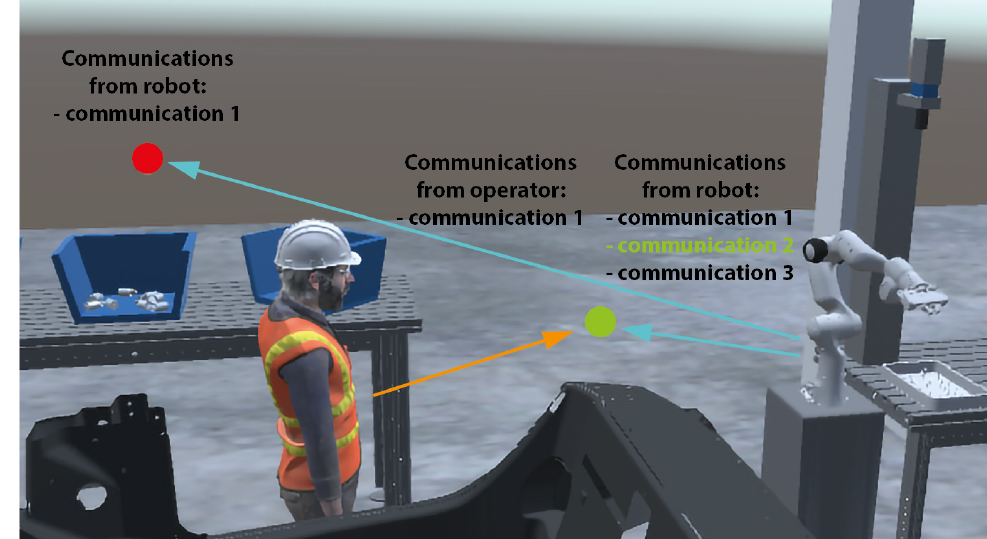
Figure 9. Example of VR-based interaction